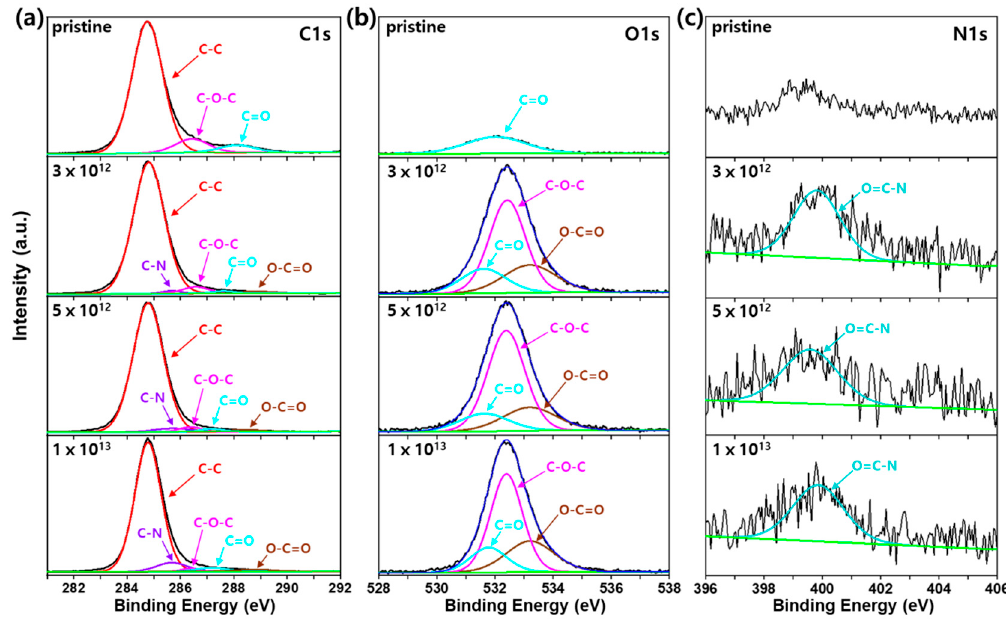
Figure 6. XPS deconvolution spectra of ( a ) C1s, ( b ) O1s, and ( c ) N1s for irradiated HDPE at various fluences.